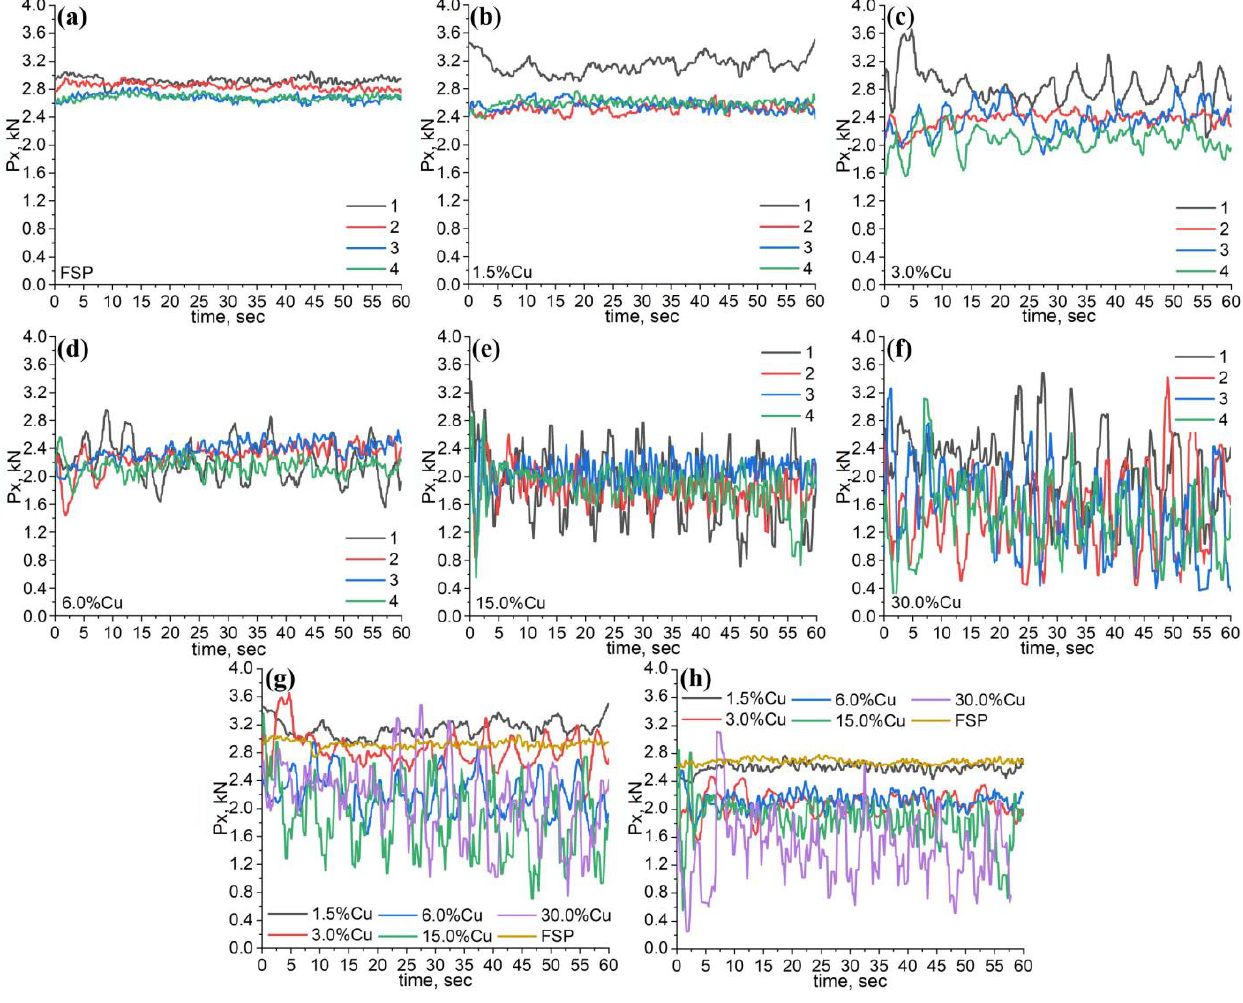
Figure 2. The plasticized metal reaction force P x vs. time for samples with 0 vol.% ( a ), 1.5 vol.% ( b ), 3.0 vol.% ( c ), 6.0 vol.%% ( d ), 15.0 vol.% ( e ), and 30.0 vol.% ( f ) Cu depending on the FSP pass number. The P x dependencies for the first ( g ) and fourth ( h ) passes on all samples.